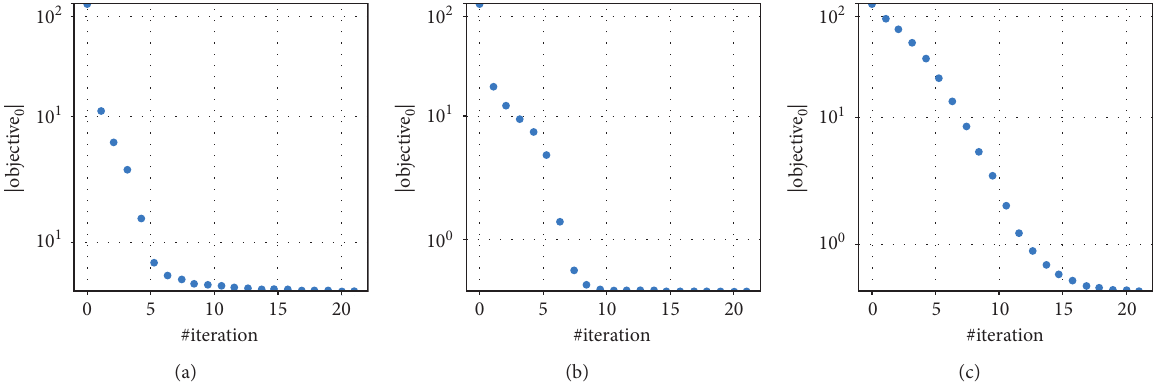
Figure 11: Comparison of networks’ convergence toward the exact solution of Example 3 using (a) Adam optimizer, (b) SGD optimizer, and (c)